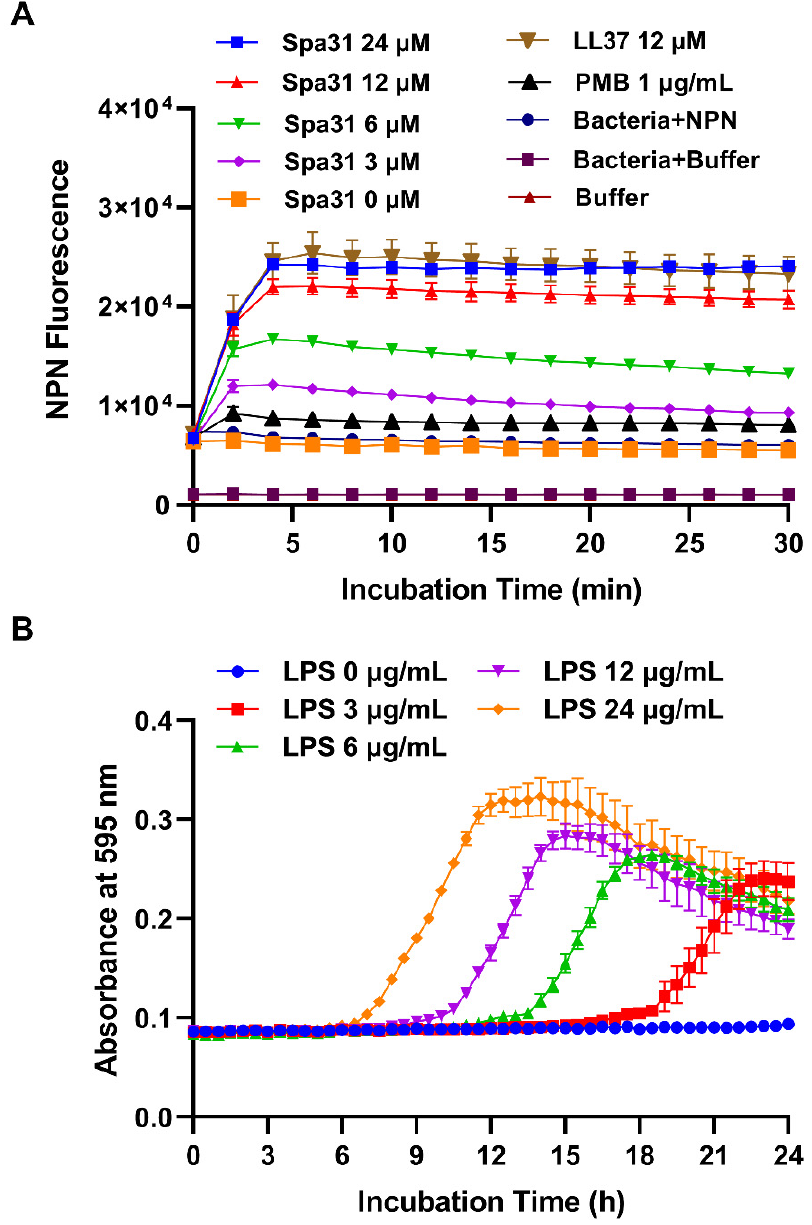
Figure 5. The outer membrane permeability of Spa31 against P. aeruginosa and the interaction between Spa31 and P. aeruginosa -derived LPS. ( A ) NPN fluorescence detection after treatment with different concentrations of Spa31. LL-37 and PMB treatment groups were used as controls. ( B ) Effect of addition of P. aeruginosa -derived LPS on the antibacterial activity of Spa31 against P. aeruginosa . Whether Spa31 interacts with bacterial surface components such as LPS prior to outer membrane penetration deserves exploration. Without the addition of LPS, Spa31 at a con- centration of 1 × MIC completely inhibited the growth of P. aeruginosa within 24 h (Figure 5B). However, when 3 μ g/mL P. aeruginosa -derived LPS was added to the medium, P. aeruginosa began to grow exponentially at approximately 21 h of incubation (Figure 5B). As the increase of the concentration of LPS (6, 12, 24 μ g/mL), the exponential growth time decreased in a dose-dependent manner (Figure 5B). The results have demonstrated that Spa31 disrupted the inner and outer membranes of P. aeruginosa , and we also found that Spa31 treatment resulted in the release of ATP (Figure 6A) and the production of ROS (Figure 6B) in a dose-dependent manner. Flow cytometry analysis showed that a 12 μ M Spa31 treatment caused 98.34% ROS production,